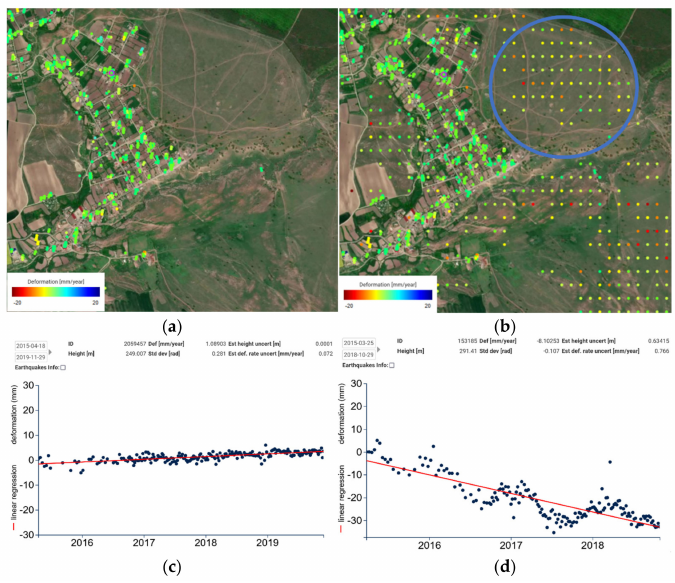
Figure 8. Infrastructure versus natural area displacement (village of Razboieni, Romania): ( a ) infrastructure only (buildings); ( b ) infrastructure and natural areas; ( c ) example of LOS dis- placement time-series of infrastructure in Figure 7a; ( d ) example of LOS displacement time-series in natural areas (blue circle in Figure